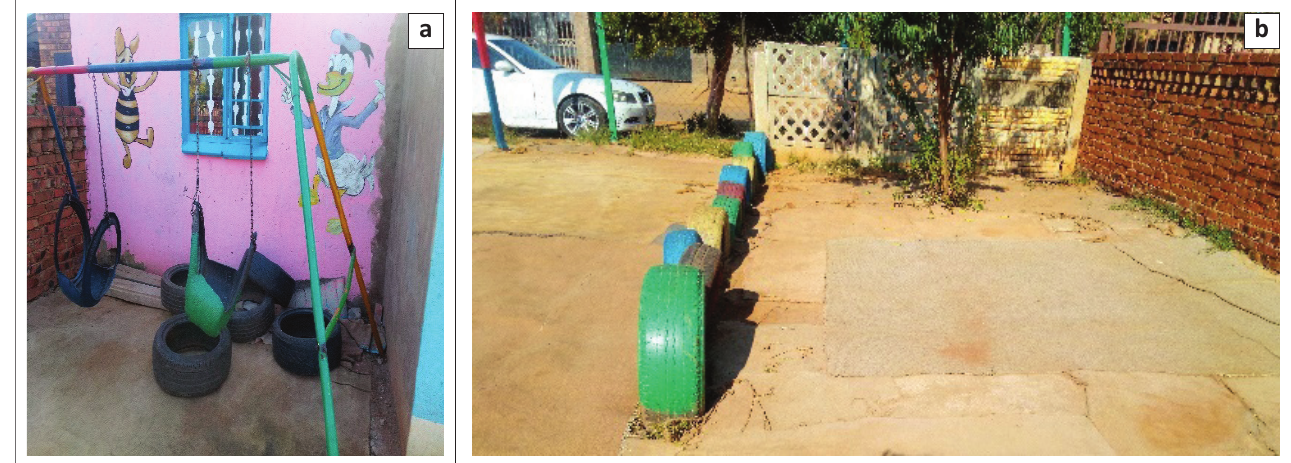
FIGURE 4: Photos (a-b) of township centre A’s outdoor play environments.